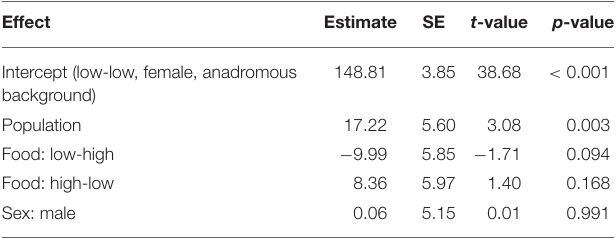
TABLE 3 | Parameter estimates with associated standard errors (SE) for the linear model testing effects of population, sex, and food treatment on plasma chloride concentration (mmol/L) of brown trout classified as smolts ( n =